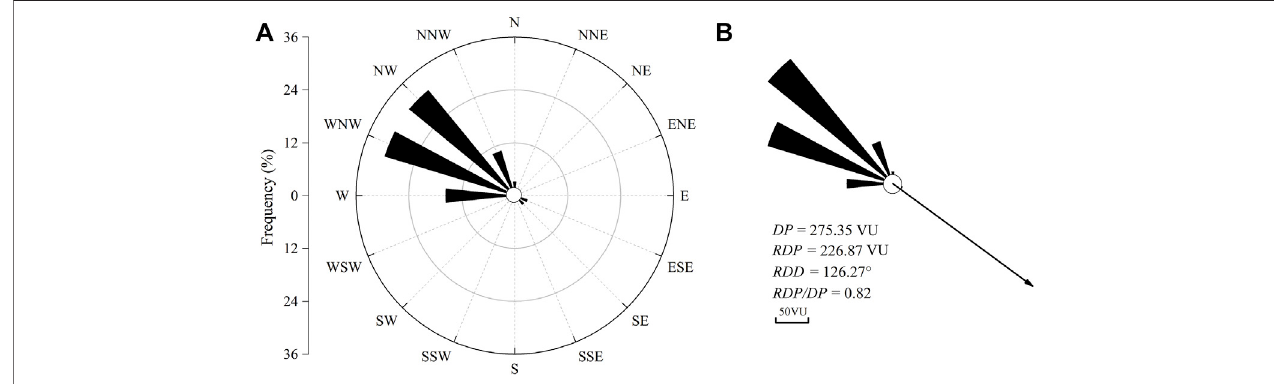
FIGURE 5 | (A) Wind rose for the distribution of threshold wind directions (i.e., for winds strong enough to entrain sediment) and (B) the annual drift potential statisticsin theareas where linear dunesand barchanscoexisted. DP ,drift potential(in vector units, VU); RDP , resultant drift potential (VU); RDD ,resultant drift potential; RDP/DP , directional